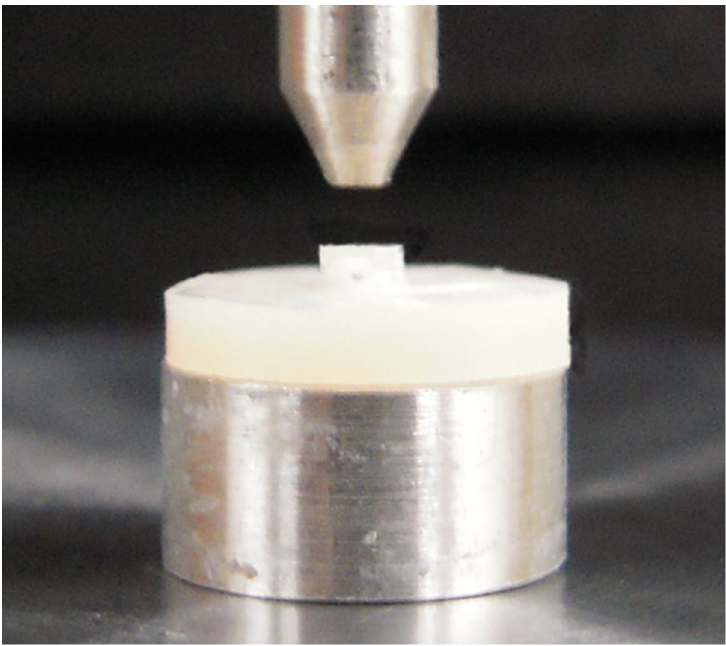
Figure 3. The photographs showing push-out shear bond strength test specimen holder and actual photograph of the